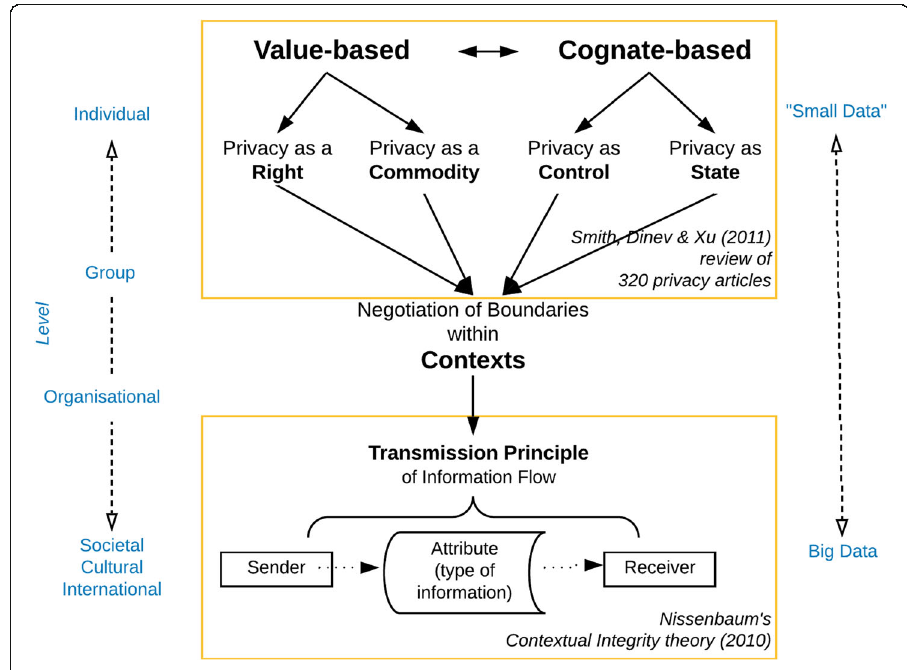
Fig. 1 Development of privacy theories towards a contextual perspective (based on Smith, Dinev, and Xu (2011) and Nissenbaum